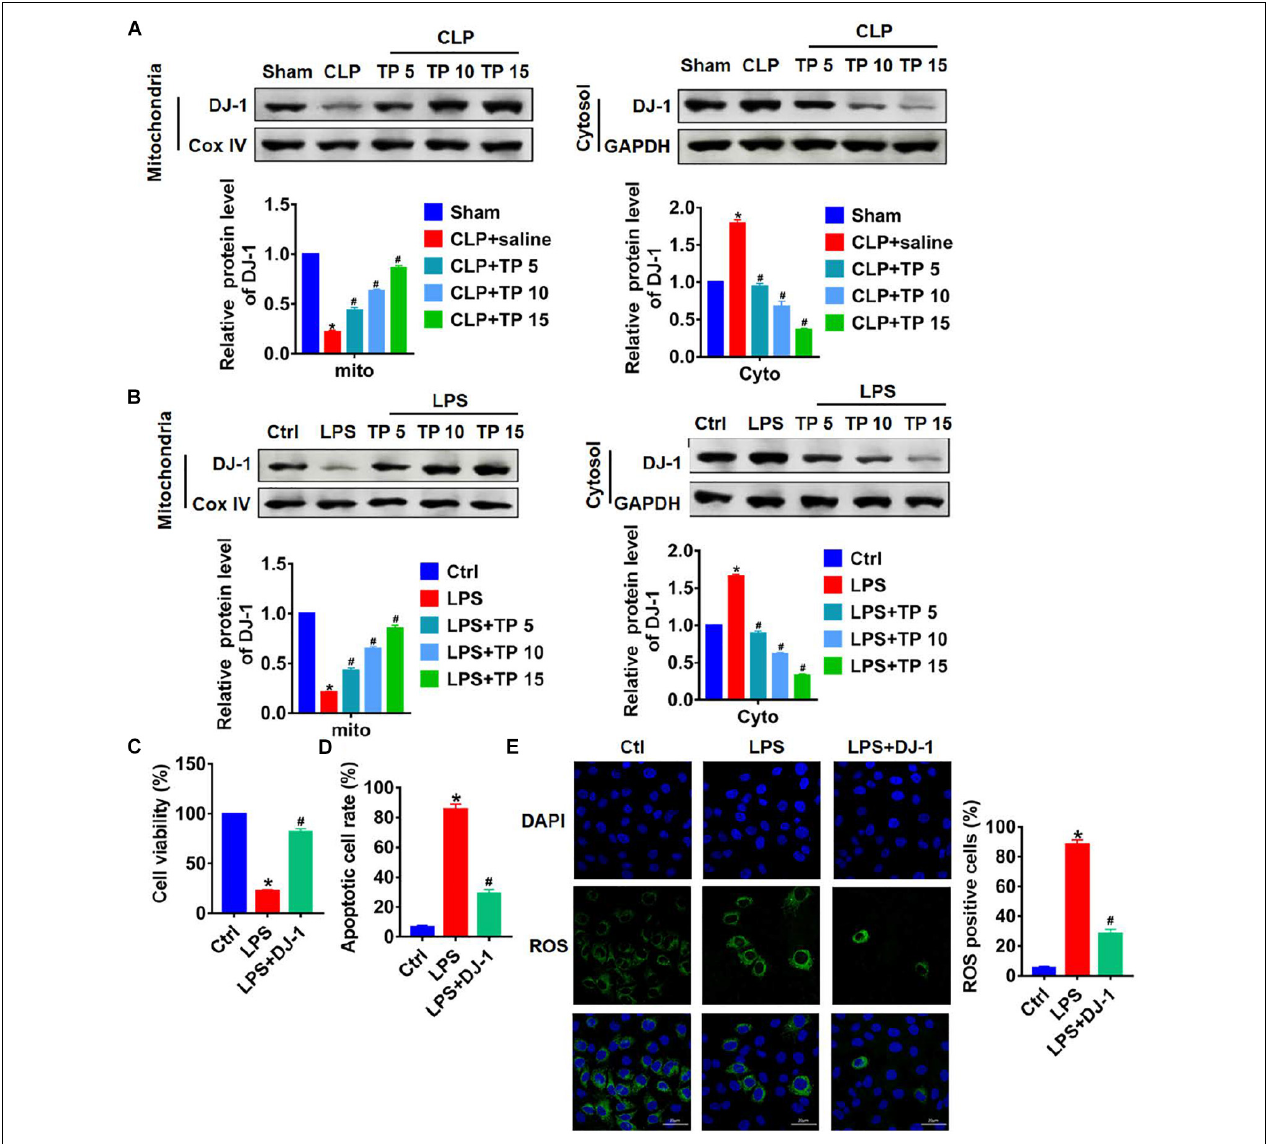
FIGURE 5 | TP prevented lung injury through modulating translocation of DJ-1 from cytoplasm to mitochondria. (A) Western blot analysis for DJ-1 protein expression of mitochondria and cytosol in lungs from rats. n = 5, * P < 0.05 vs. Sham, # P < 0.05 vs. CLP. (B) Western blot analysis for DJ-1 protein expression of mitochondria and cytosol in L2 cells. n = 5, * P < 0.05 vs. control, # P < 0.05 vs. LPS. L2 cells were transfected with DJ-1 or NC and treated with LPS. (C) MTT for cell viability. n = 5, * P < 0.05 vs. control, # P < 0.05 vs. LPS. (D) Apoptosis cell numbers were tested by TUNLE staining. n = 5, * P < 0.05 vs. control, # P < 0.05 vs. LPS. (E) ROS assay for L2 cells. n = 5, * P < 0.05 vs. control, # P < 0.05 vs.